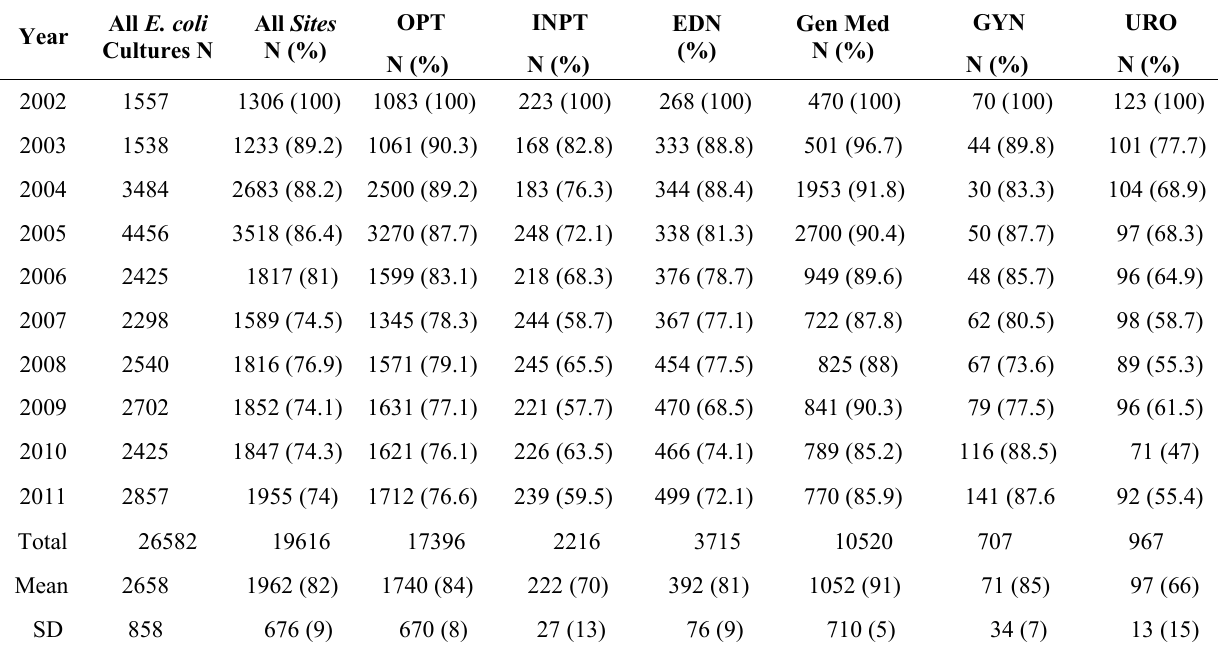
Table 4. Ciprofloxacin susceptibilities of adult E. coli positive urinary cultures by site (N = number, OPT = outpatient, INPT = inpatient, ED = emergency department, Gen Med = general medicine, GYN = gynecology, URO =